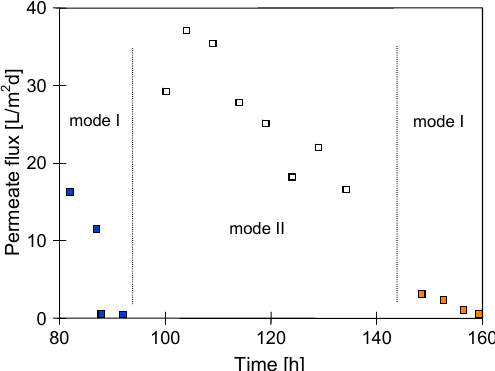
Figure 4. Changes of the permeate flux during MD of NaCl saturated (at 363 K) solutions. Module MD2 assembled inside fluidized-bed crystallizer. Mode I.